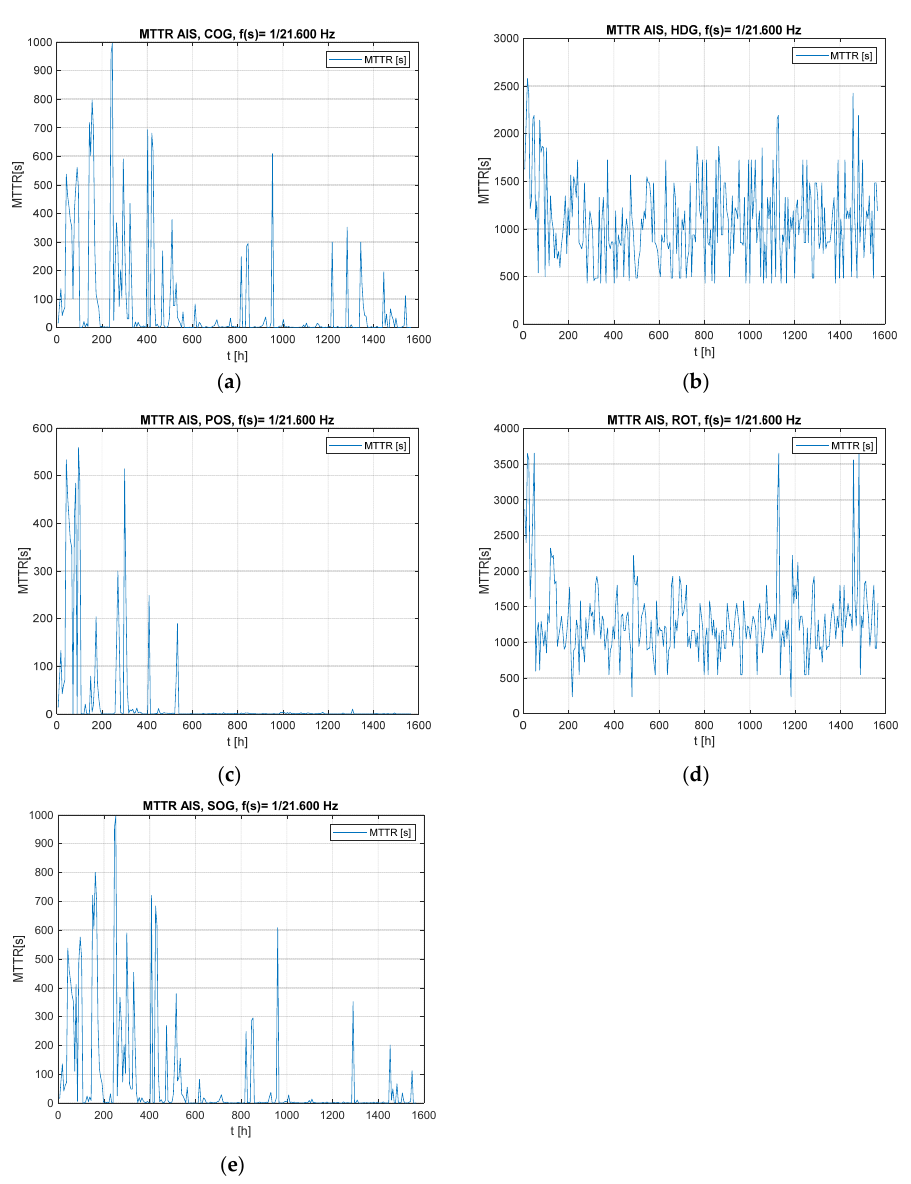
Figure 7. The mean time to repair the AIS service for five navigation parameters ( a ) COG. ( b ) HDG. ( c ) POS. ( d ) ROT. ( e ) SOG.